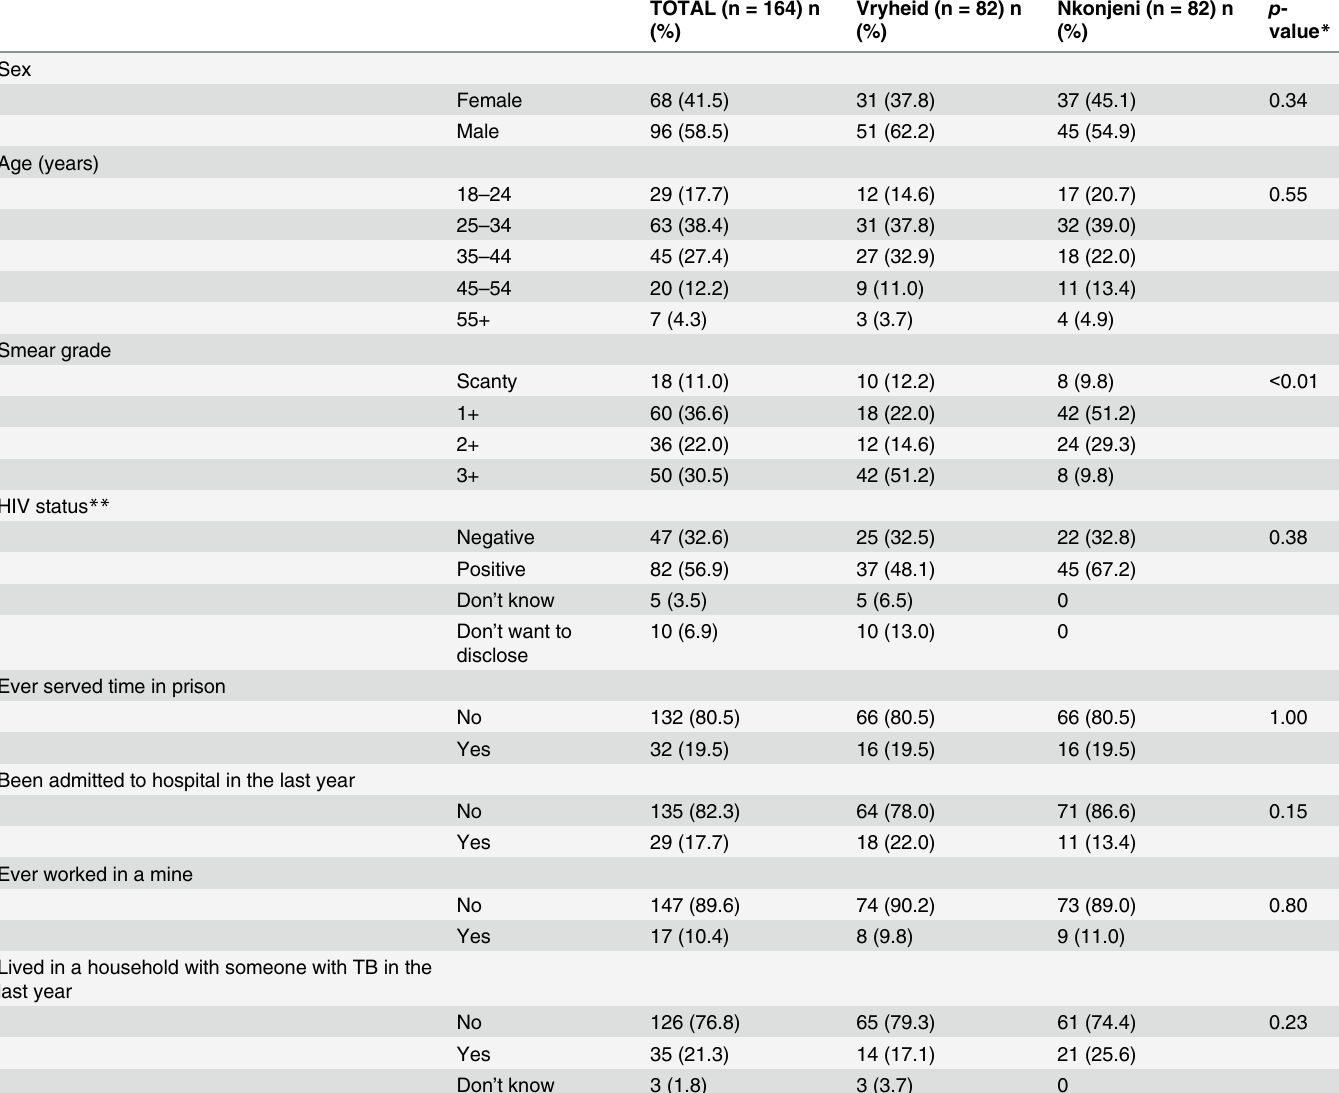
Table 1. Participant characteristics at prospective sites, KwaZulu-Natal Province, South Africa (n =